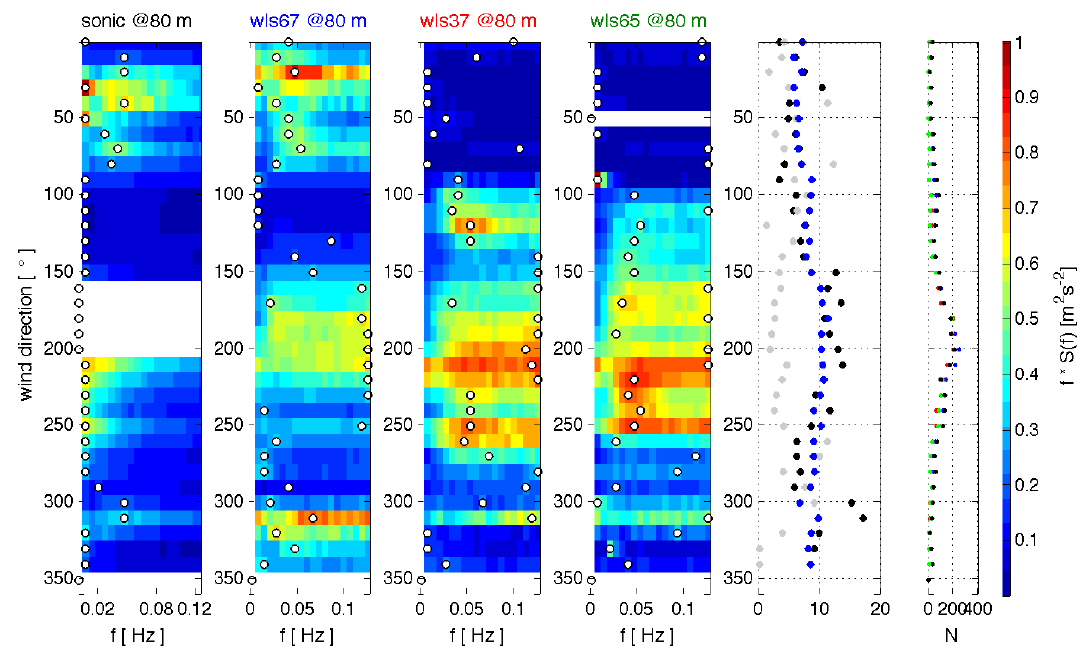
Figure 11. Composites of hourly energy spectra of u at 80m for all wind direction bins from wls67, wls37 and wls65 (from left to right). White circles indicate the maximal spectral energy density of each direction bin. Additional subplots show wind direction bin averaged horizontal wind speeds at 108m (blue in (m · s − 1 )), power output (black in (MW/100)) and blade pitch angle (gray in ( ◦ )) of wind turbine WT6 and the number of averaged hours in each bin for wls67 (blue), wls37 (red) and wls65